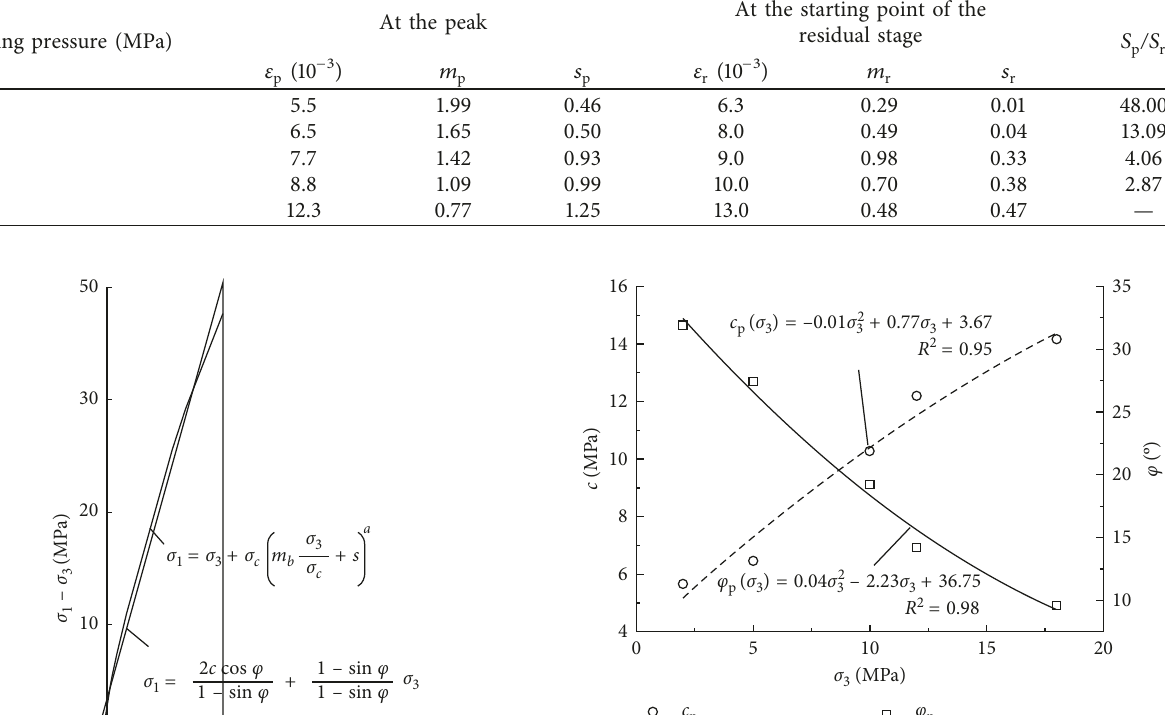
m, s at the peak position and at the starting residual stage. ( ) At the peak